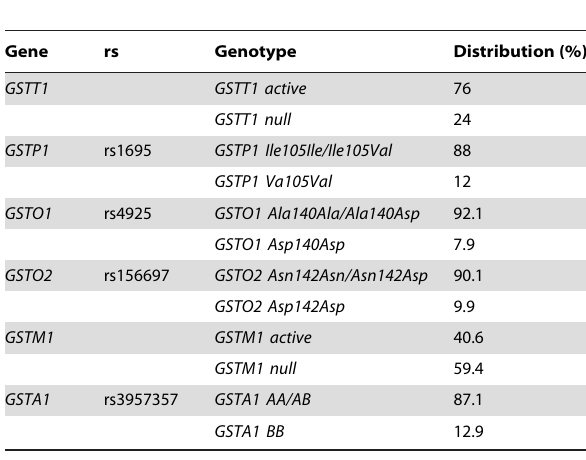
Table 2. Glutathione S-transferase (GST) genotype